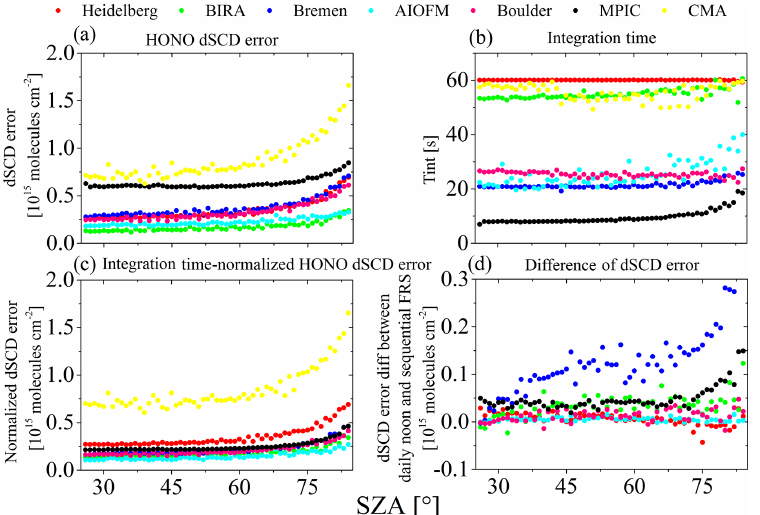
Figure 4. Comparison of different fit errors as a function of the SZA between participating instruments: (a) Averaged HONO dSCD fit errors for spectra at 1 ◦ elevation angle using a daily noon FRS, (b) integration time, (c) normalized HONO dSCD fit errors according to an integration time of 1min, (d) differences of the HONO dSCD fit errors with either a daily noon FRS or a sequential